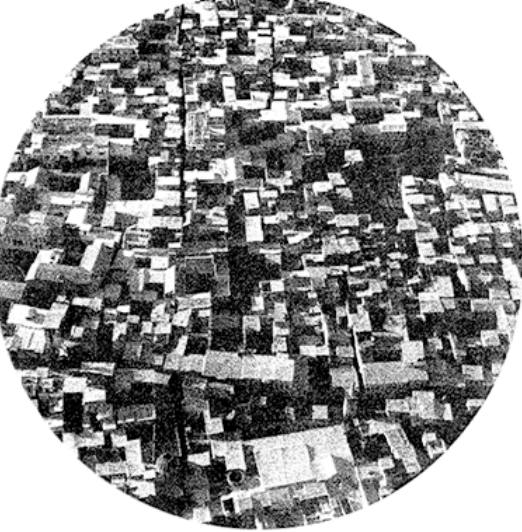
Figure 3. Photograph of the ancient section of the city of Damacus. Weingart took this picture in 1966 and noticed that its texture resembled to some of his typographical compositions (see Figure 2 and